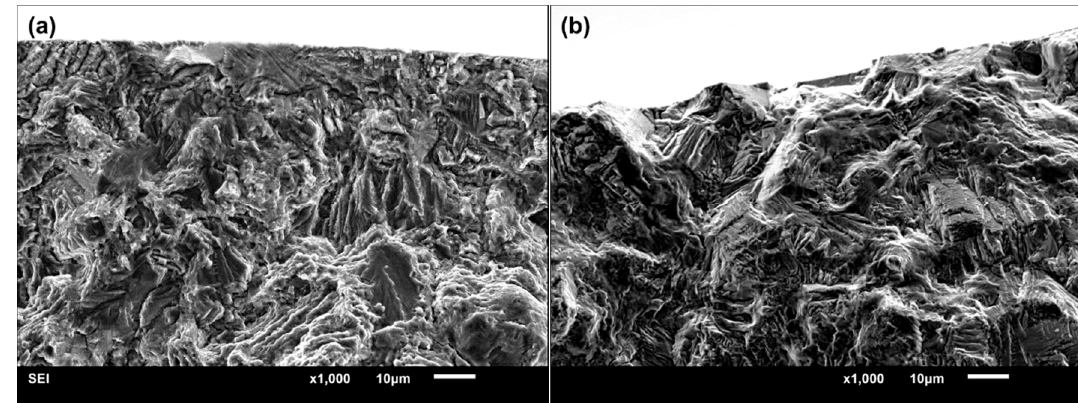
Figure 6. Typical fractography of single-point surface crack initiation region with blurry facet feature at R = − 1, ( a ) smooth specimen ( σ a = 530 MPa, N f = 2.5939 × 10 6 cycles) and ( b ) notched specimen ( σ a = 320 MPa, N f = 3.4223 × 10 6